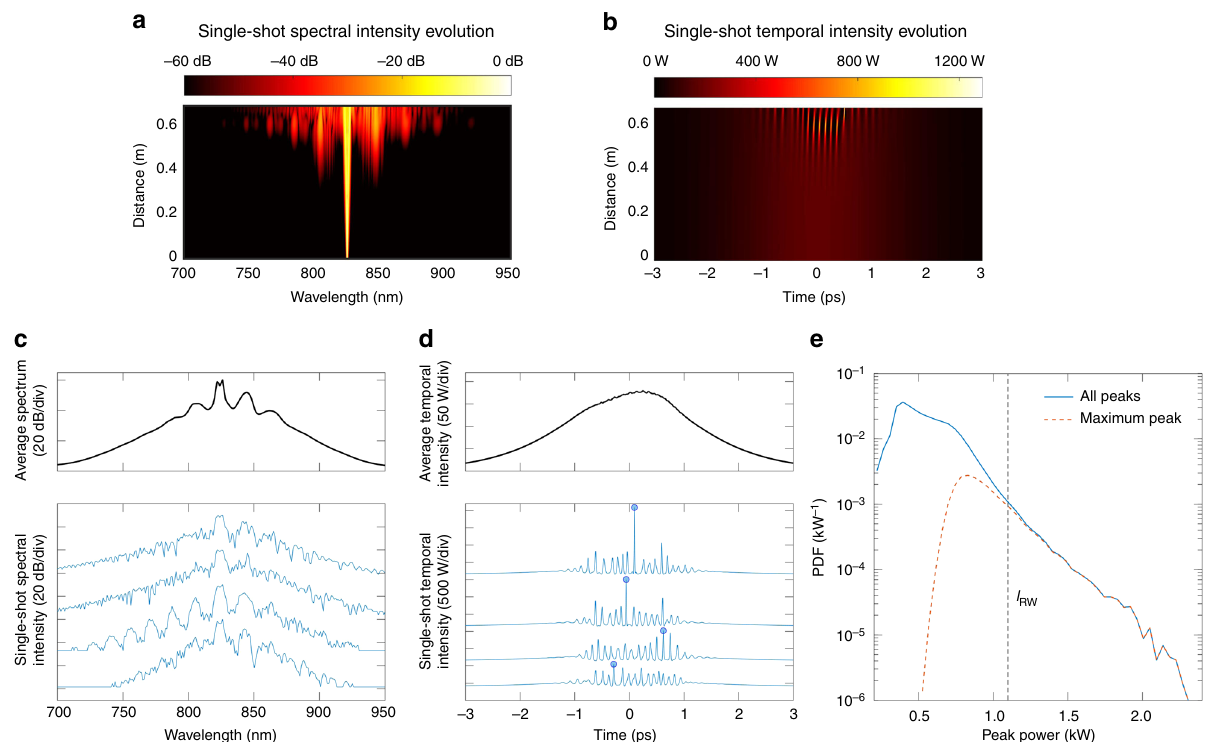
Fig. 1 Simulated MI dynamics from picosecond pulse propagation in optical fi bre. a , b Results are shown from a single simulation illustrating spectral and temporal evolution over 0.68 m of propagation. c Spectral data at the fi bre output from multiple simulations: the top fi gure shows the average spectrum over 50,000 realisations; the bottom fi gure shows the spectral output from four realisations to illustrate the complexity of the spectra and the shot-to-shot variations. d Temporal data at the fi bre output from multiple simulations: the top fi gure shows the average temporal intensity over 50,000 realisations; the bottom fi gure shows the temporal intensity from the four realisations corresponding to c to illustrate the strong temporal modulation observed. The peak intensity (maximum instantaneous peak power) in each case (shown by a circle) is the parameter we are aiming to predict from the corresponding single- shot spectra. e Calculated probability density function of temporal intensity peaks from simulation data. The solid line shows results from all peaks (over a 1.5 ps window), while the dashed line shows only the distribution of the maxima temporal intensity peaks. I RW marks the rogue wave intensity threshold, de fi ned as twice the mean intensity of the highest third of all the temporal